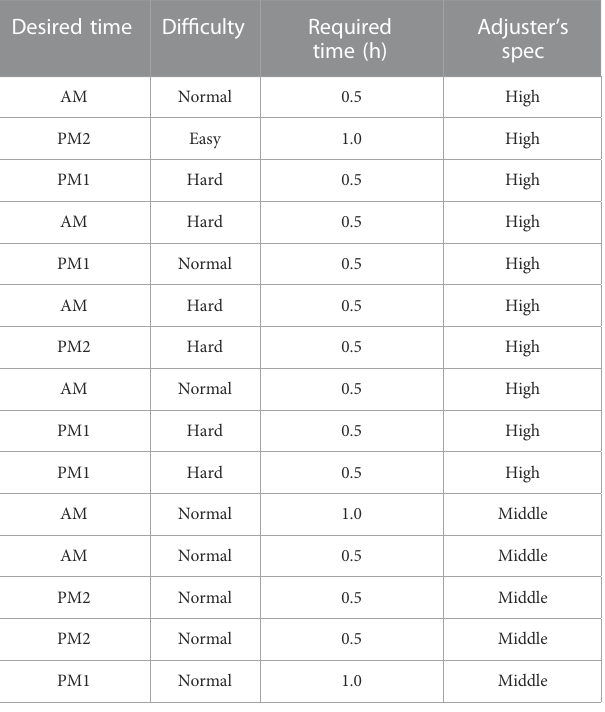
TABLE 3 Data for each of the three clusters in instance No. 1 of the base case: the top fi ve, middle fi ve, and bottom fi ve points belong to different clusters (corresponding to red, blue, and green in Figure 3).